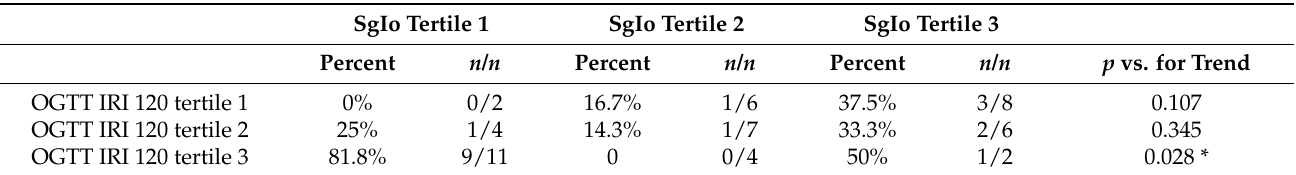
Table 8. The proportions of the participants with snacking habits in the SgIo tertile categories according to OGTT IRI 120 tertile category. SgIo Tertile 1 SgIo Tertile 2 SgIo Tertile 3 Percent n / n Percent n / n Percent n / n p vs. for Trend OGTT IRI 120 tertile 1 0% 16.7% 1/6 37.5% 3/8